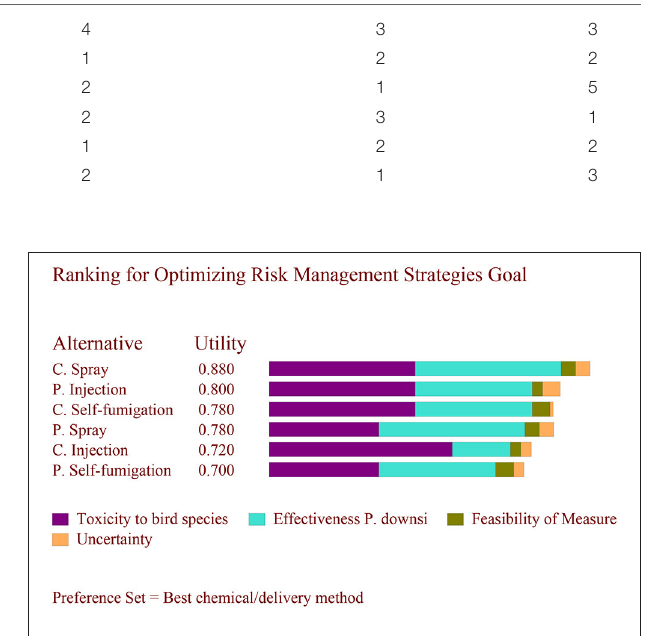
FIGURE 1 | Ranking of the six alternatives considering the weights from Scenario A.